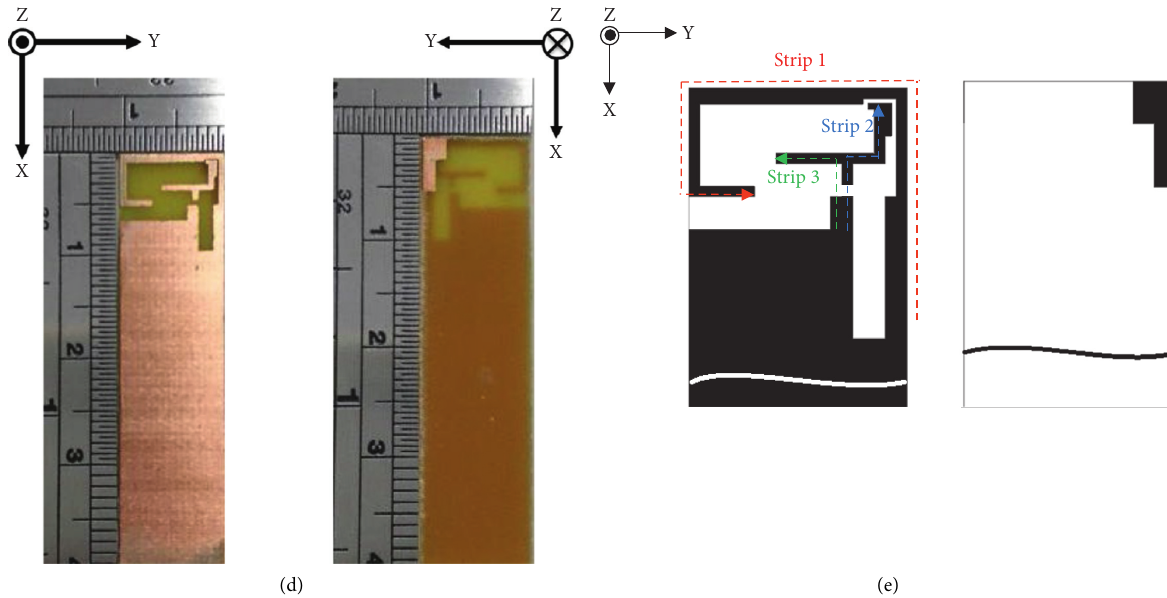
Figure 1: Construction of the suggested planar antenna design: (a) full view of the planar antenna geometry; (b) planar antenna design architecture with equipment layout; (c) specific dimensions on the top and bottom layers; (d) multiband antenna manufactured by shooting with both sides view; (e) the planar antenna includes three strips and one pad on both